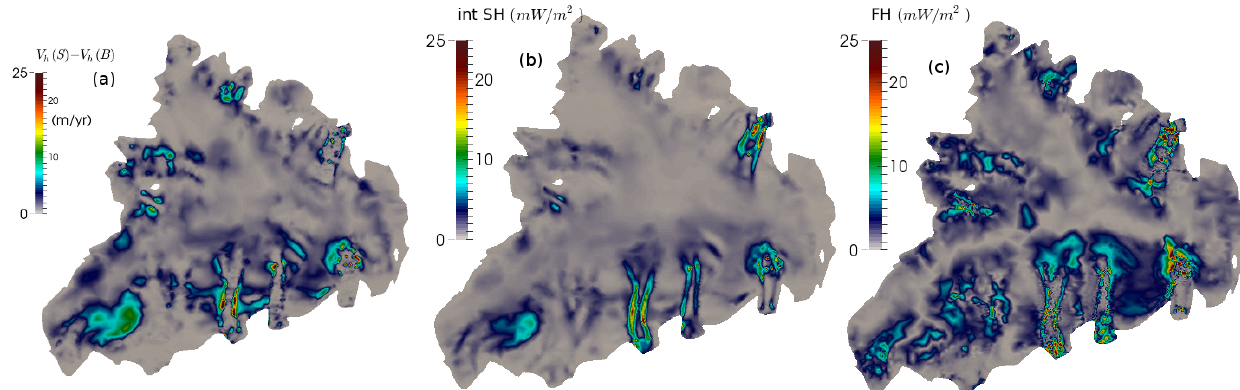
Figure 12. (a) Difference between surface and bedrock velocities, i.e. the velocity due to deformation in 1995. Vertically integrated strain heat (b) and friction heat at the bedrock (c) in the simulation 1995ss